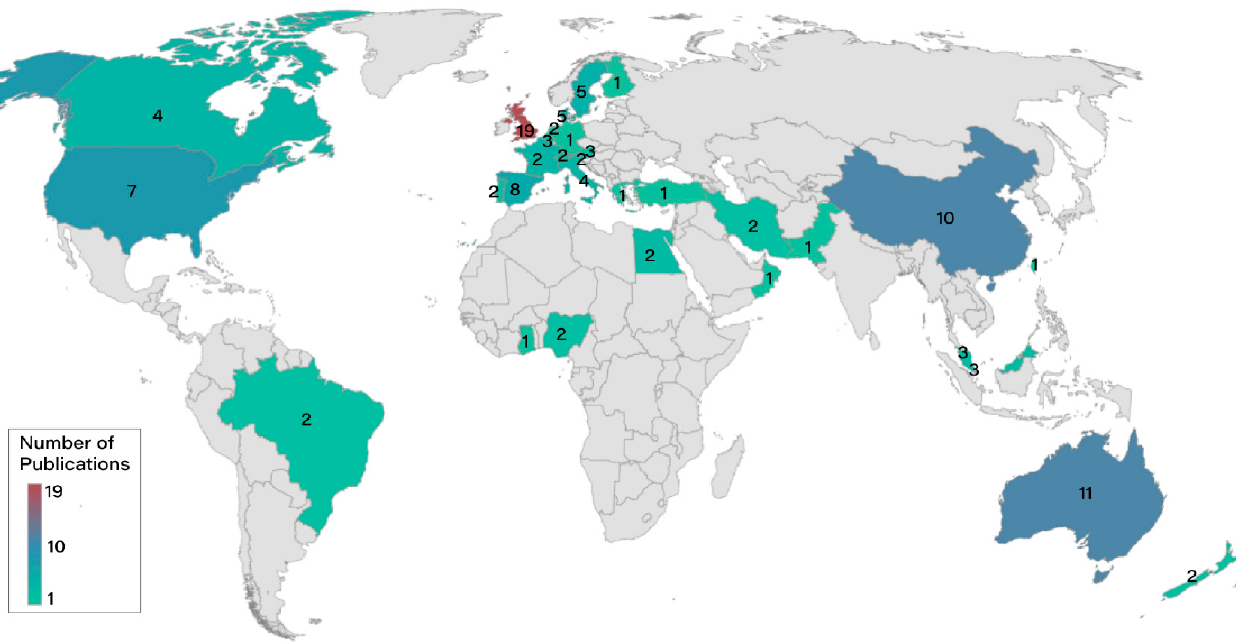
Figure 3. Geographical distribution of reviewed papers.